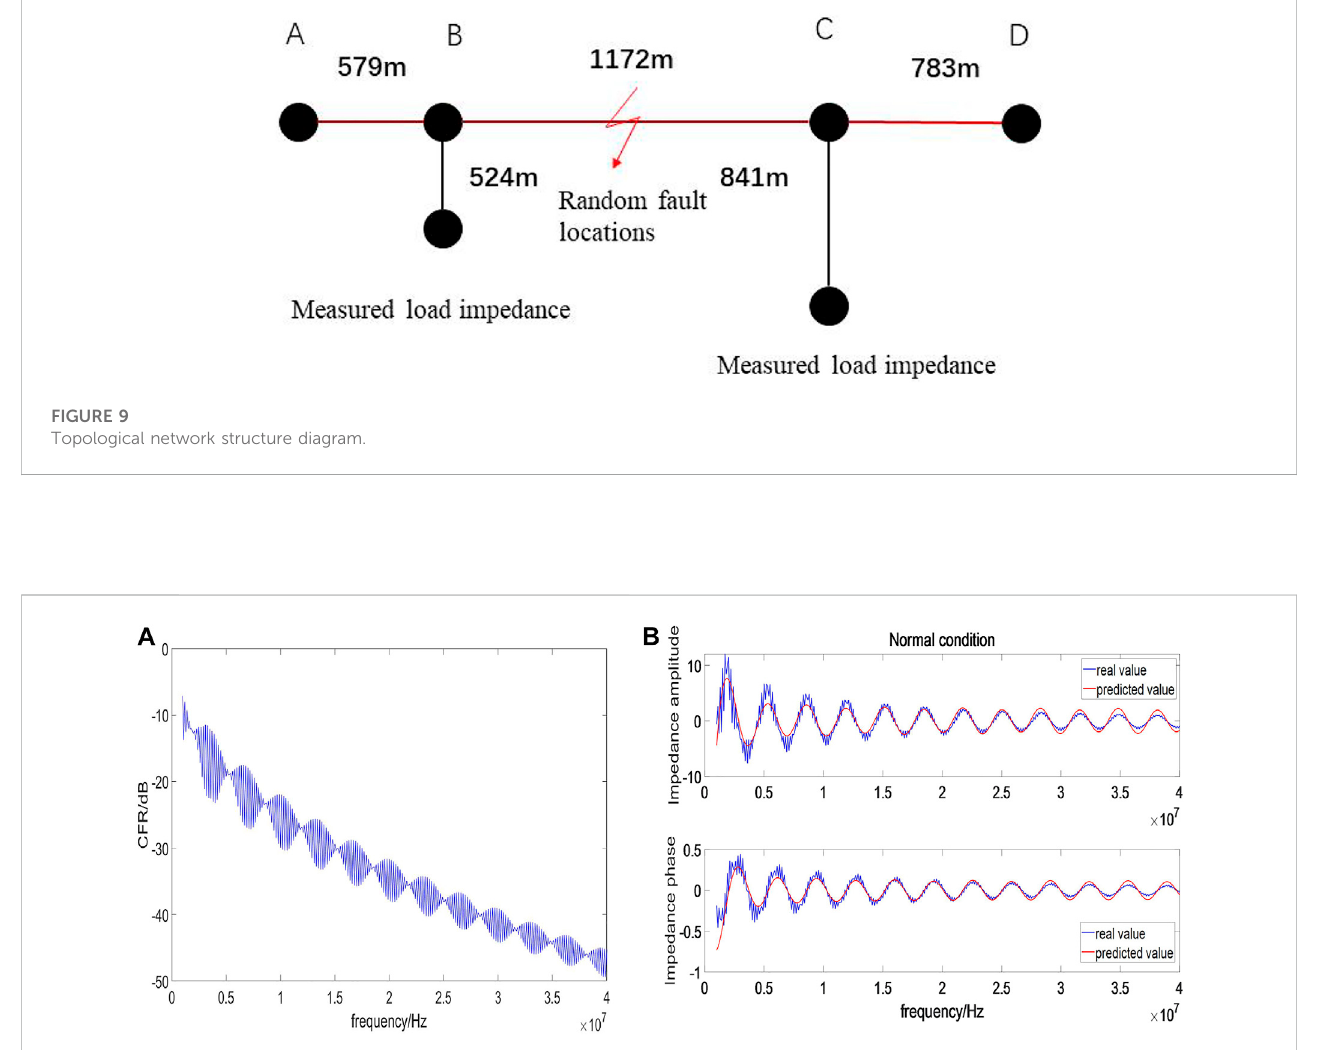
FIGURE 10 The data under normal conditions, (A) is the CFR data under normal conditions, (B) is the impedance date under normal